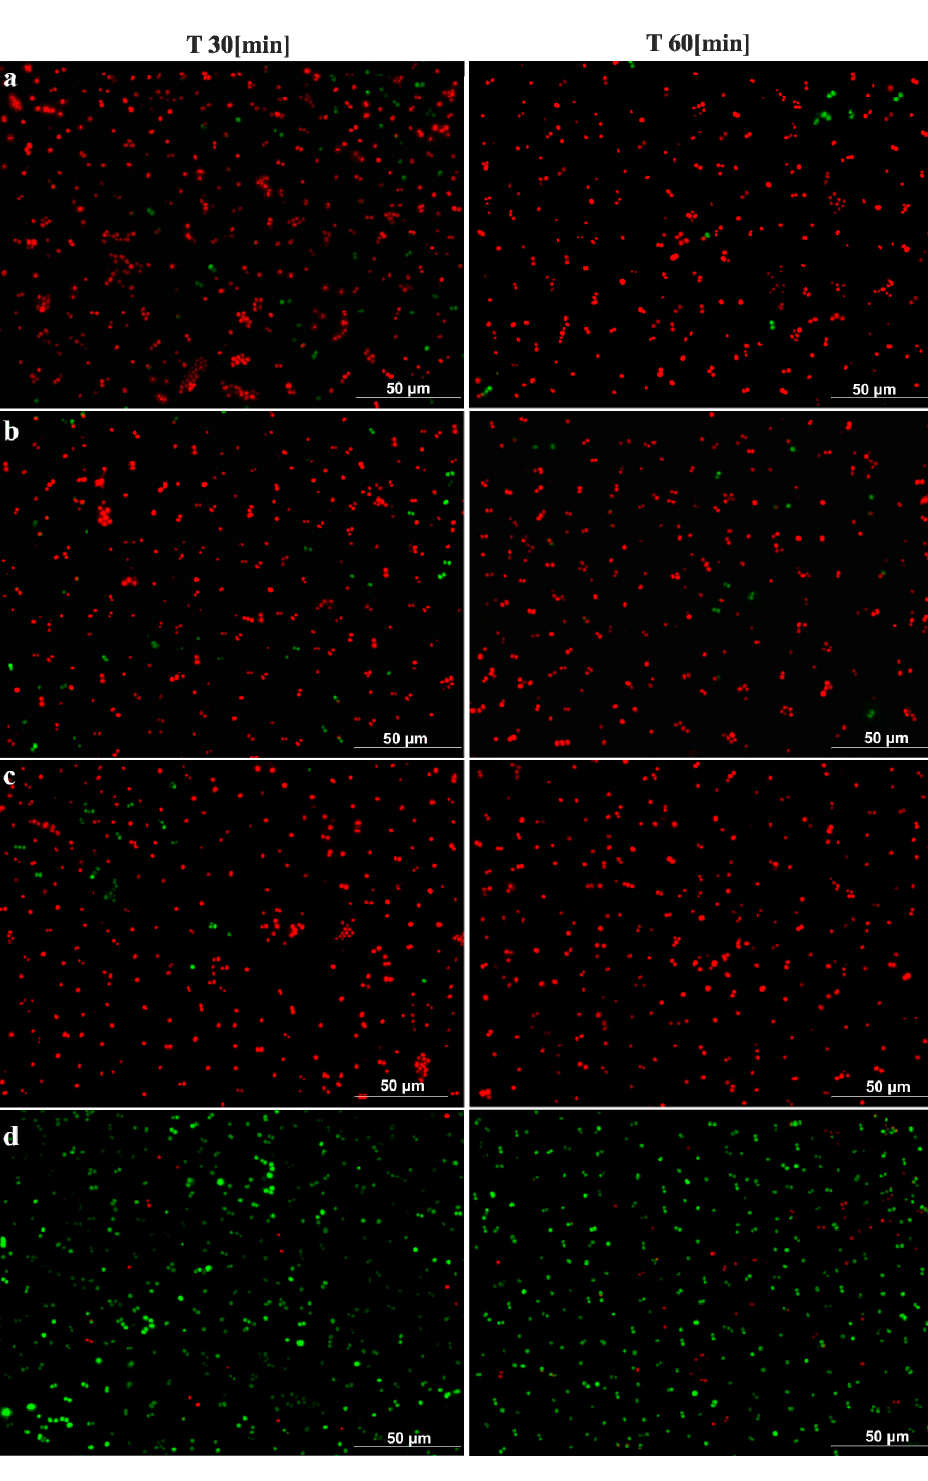
Figure 6. Photographs showing the survival rate of S. aureus in selected time periods on: Cu-ETP ( a ), CuZn37 ( b ), CuZn6 ( c ), and stainless steel ( d ).